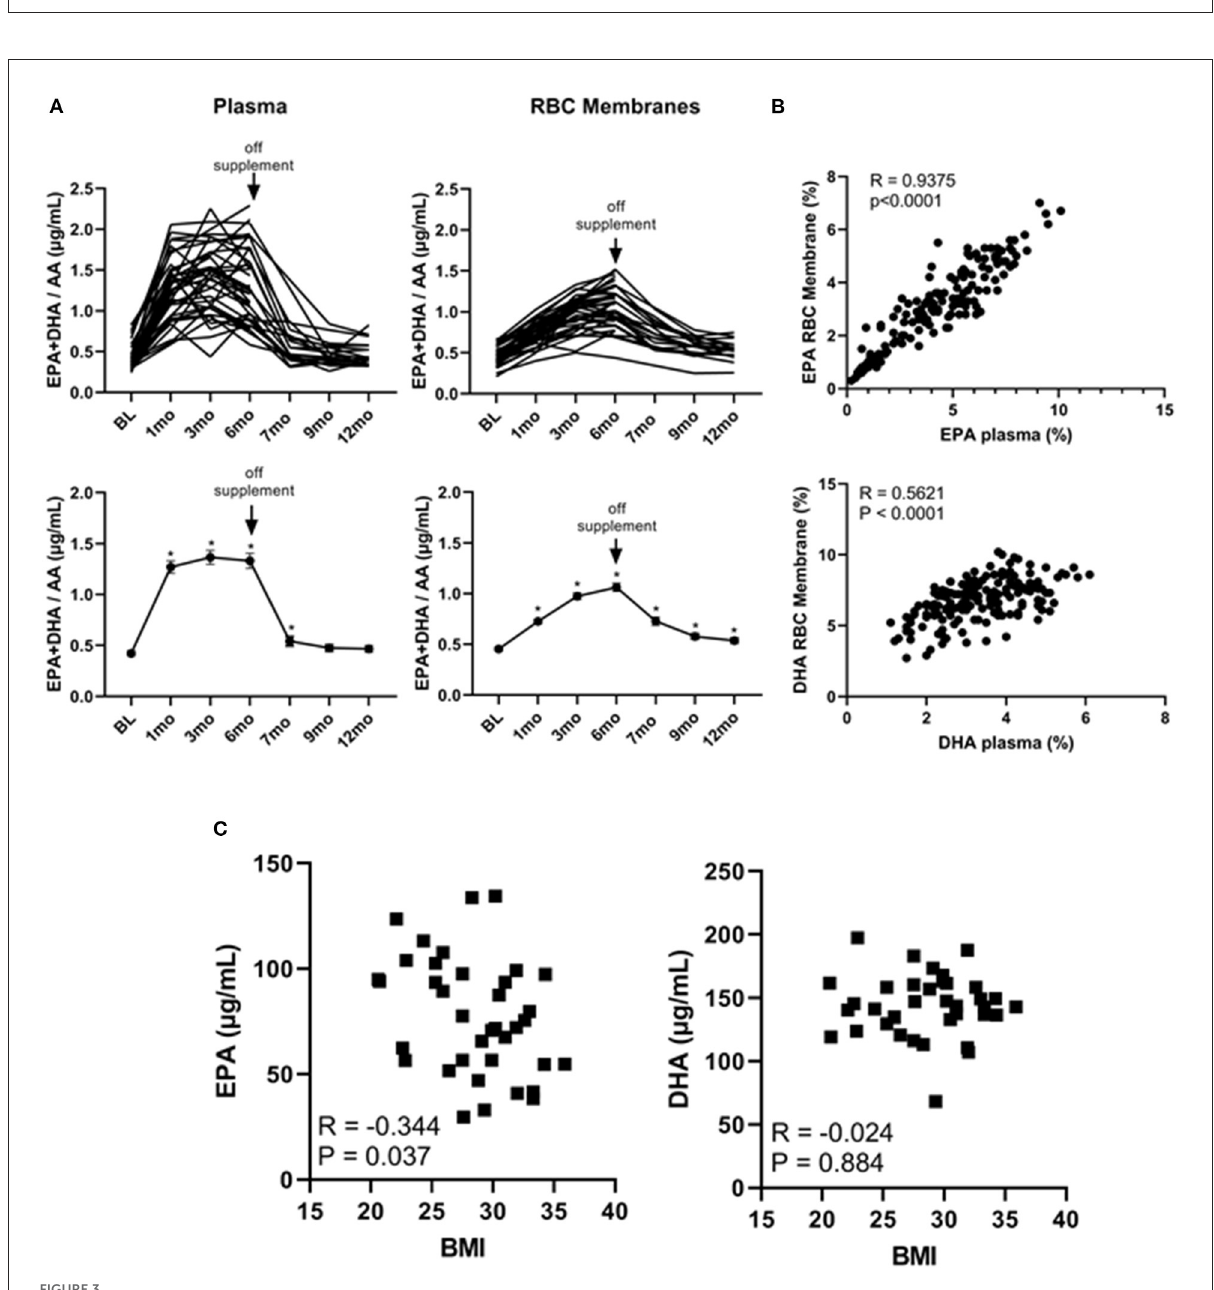
FIGURE3 Omega 3 supplements significantly increase plasma and RBC membrane levels of EPA + DHA/AA and the RBC membrane EPA levels inversely correlate with initial BMI. (A) Upper panel: Individual plasma and RBC membrane EPA + DHA/AA levels over time from participants taking omega 3 supplements. Lower panel: Average plasma and RBC membrane EPA + DHA/AA levels over time from participants taking omega 3 supplements. All average values shown are the mean ± SEM. (B) Upper panel: Correlation between EPA levels (as a percent of total FAs) in RBC membranes and in plasma of participants during the omega 3 supplementation period. Lower panel: Correlation between DHA levels (as percent of total FAs) in RBC membranes and in plasma. (C) Correlation between the concentration of EPA or DHA (in µ g/mL) in RBC membranes of participants throughout omega 3 supplements and their initial BMI. *Denotes significant ( P < 0.05) difference when compared to baseline